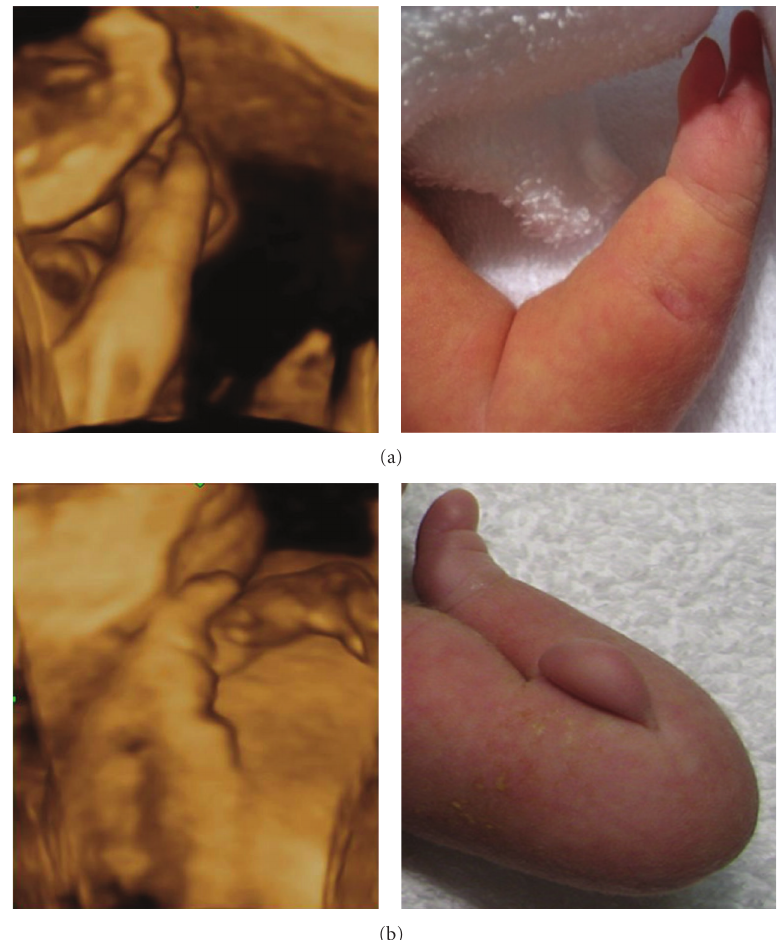
Figure 2: Abnormalities of the forearms in 3D ultrasonography and newborn. (a) Ectrodactylia and (b) monodactylism.